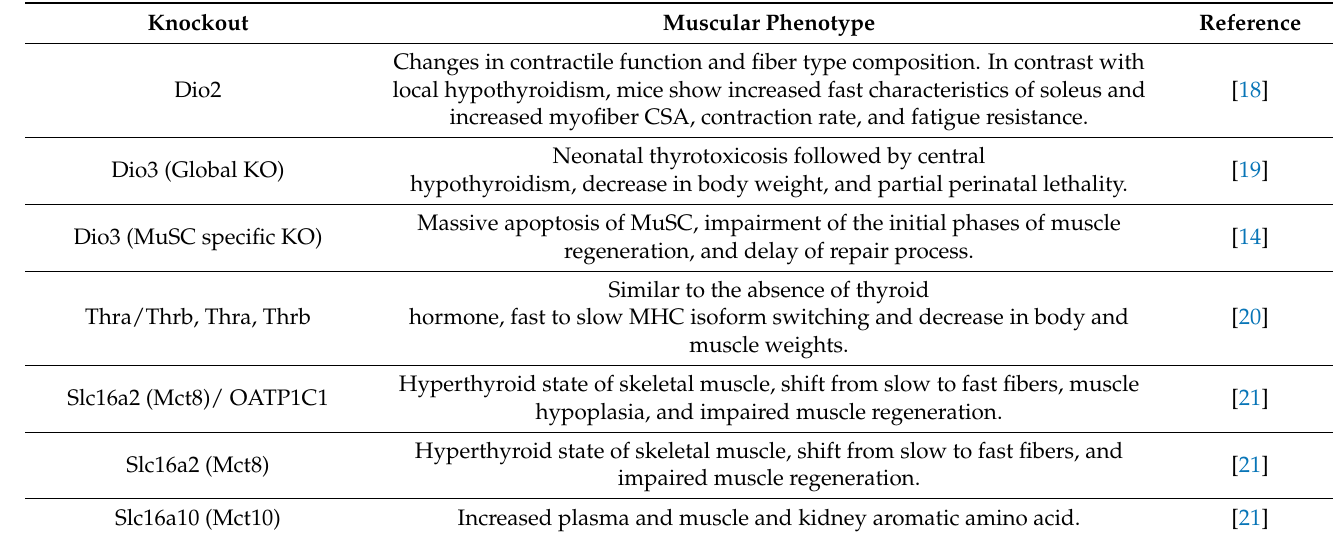
Table 1. Muscular phenotype of murine thyroid-hormone-signaling knockout models. Muscular Phenotype